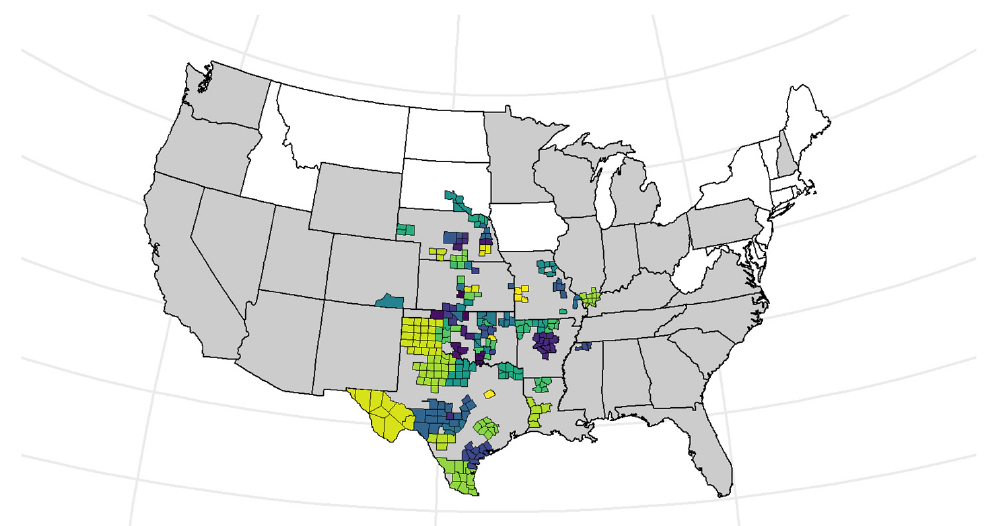
Figure 2. This map shows the 32 states with prescribed fire councils (PFCs). States that are gray have PFCs; those that are white do not. This map also shows known prescribed burn associations (PBAs) that are active in the counties of the Great Plains and adjacent regions. The colors do not indicate anything. This map is not intended to be used to identify specific PBAs so a legend is not included. A complete list of the PBAs presented here can be found in Table S1 in the Supplemental Materials. The Great Plains Fire Science Exchange website maintains an updated map of only PBAs across the country